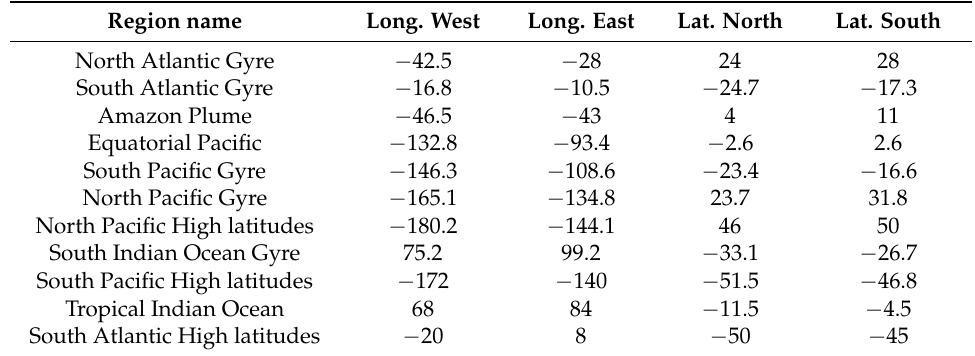
Table 5. Longitude and latitude (in ◦ ) limits for the regions of interest in Figure 2.